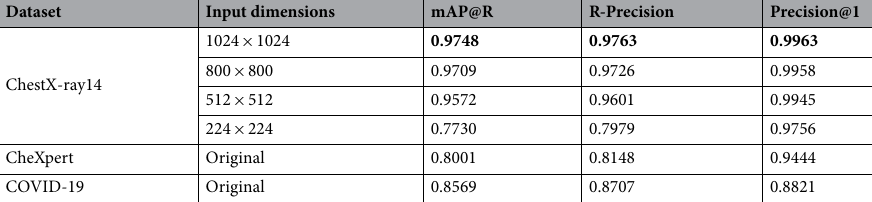
Table 3. Overview of the obtained results for our image retrieval experiments. In this table, we report the mAP @ R , the R -Precision, and the Precision@1. The first 4 rows show the results on the ChestX-ray14 dataset for different image resolutions used for evaluation. The fifth row shows the outcomes on the CheXpert dataset. The last row indicates the results on the COVID-19 Image Data Collection. Bold text represents the overall highest performance metrics.